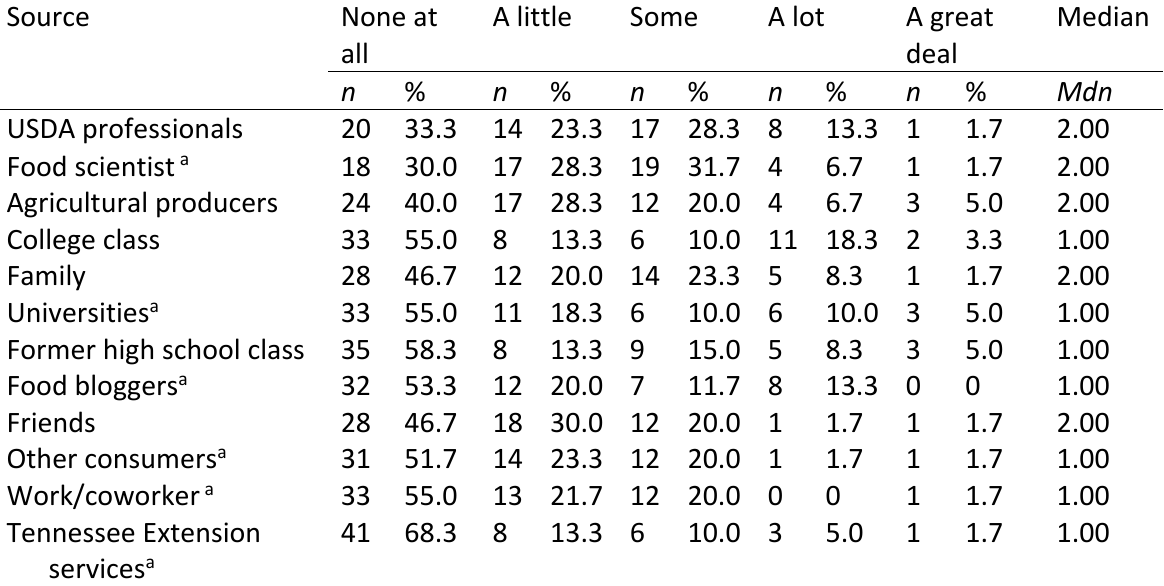
Information Source Use by Respondents with Positive-Leaning Perceptions of GMO Products (N =